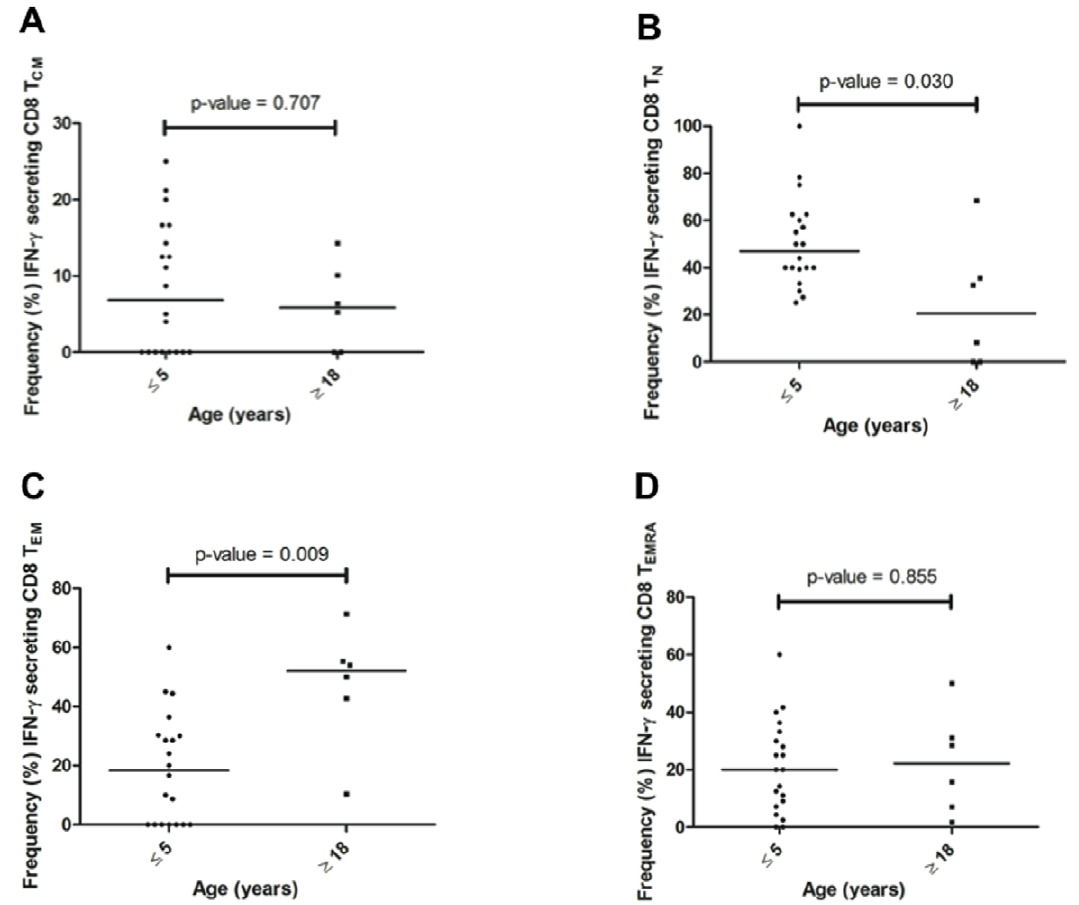
Figure 7. Proportion of MSP1 42 -specific IFN- c secreting CD8 + T cell subsets across age groups. IFN- c responses to MSP1 42 (3D7 strain) were determined ex vivo by intracellular staining and flow cytometric analysis of cell surface marker expression. T cell subsets were defined by expression of CD45RA and CD62L surface markers: ( A ) T CM (CD8 + , CD45RA 2 , CD62L + ); ( B ) T N (CD8 + , CD45RA + , CD62L + ); ( C ) T EM (CD8 + , CD45RA 2 , CD62L 2 ); and ( D ) T EMRA (CD8 + , CD45RA + , CD62L 2 ). The predominant IFN- c expressing CD8 + T cell in adults displayed a T EM phenotype and this was significantly different than children ( P =0.009) who, similar to CD4 + T cells, had IFN- c expression in response to MSP1 42 from all four CD8 + T cell subsets with a predominance of phenotypically naı¨ve secreting T cells ( P =0.030) compared to adults. IFN- c responses observed for CD8 + T CM and T EMRA were of similarly low frequencies across age groups.